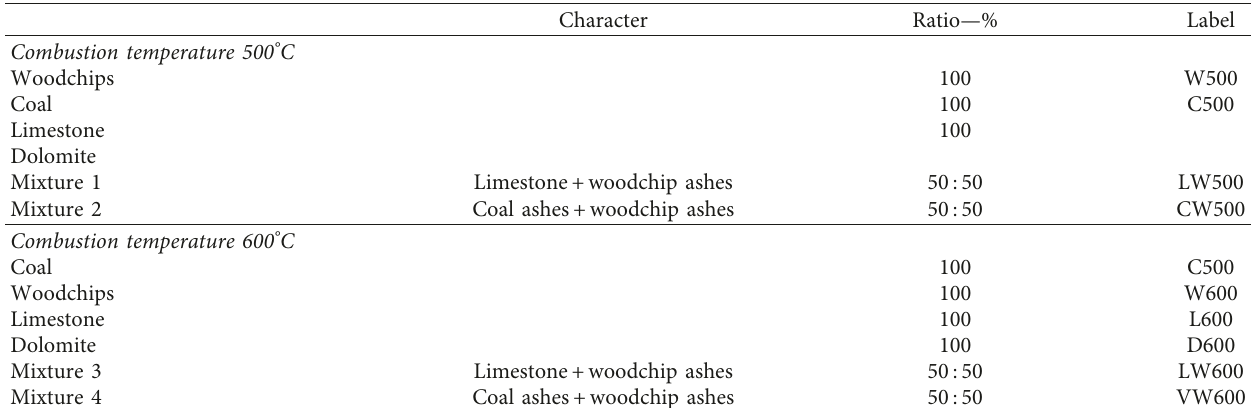
Table 4: The designation of model